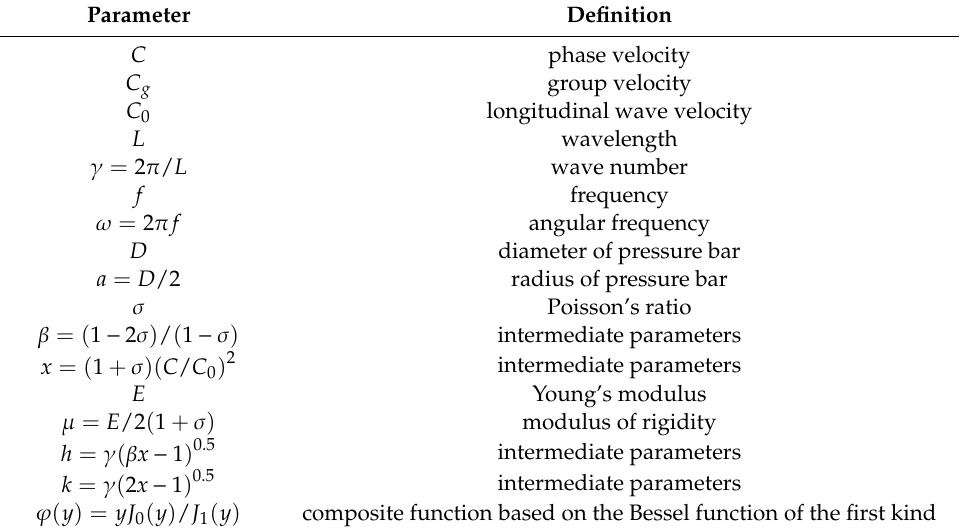
Table 1. Definition of elastic longitudinal stress wave parameters in the bar.